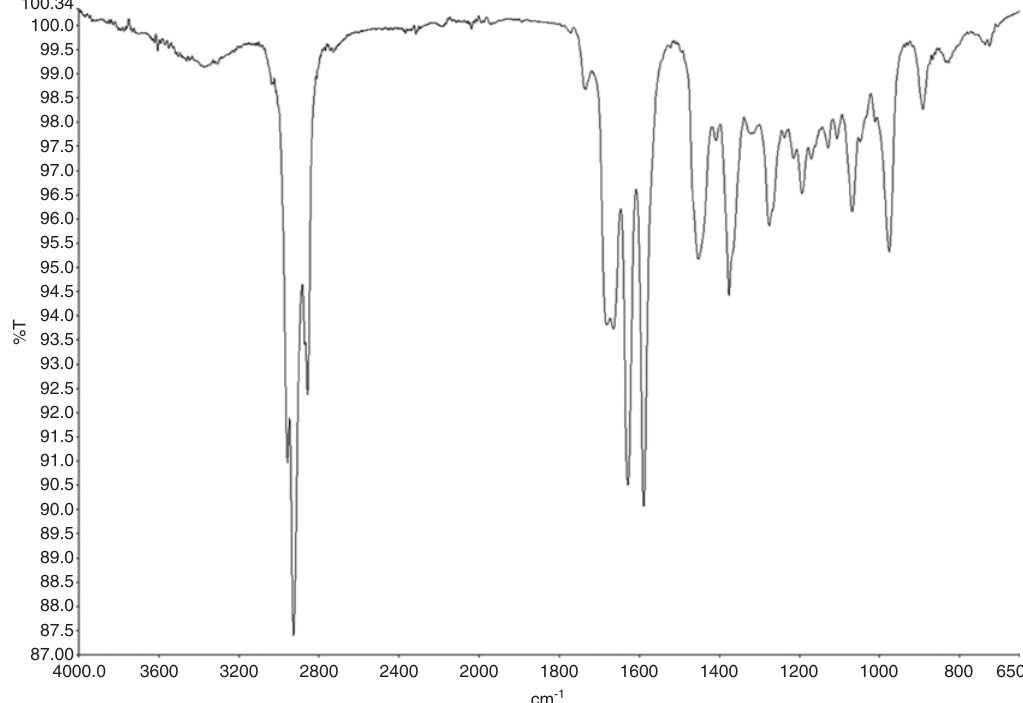
Figure 7: Fourier transform infrared (FTIR) spectrum of isolated 11,15-dimethyl-hexadeca-8,10,14-trien-7-one